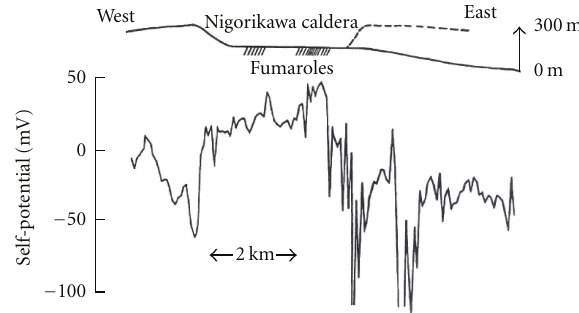
Figure 6: Topographic section and self-potential profile across the Nigorikawa caldera measured in 1978, after